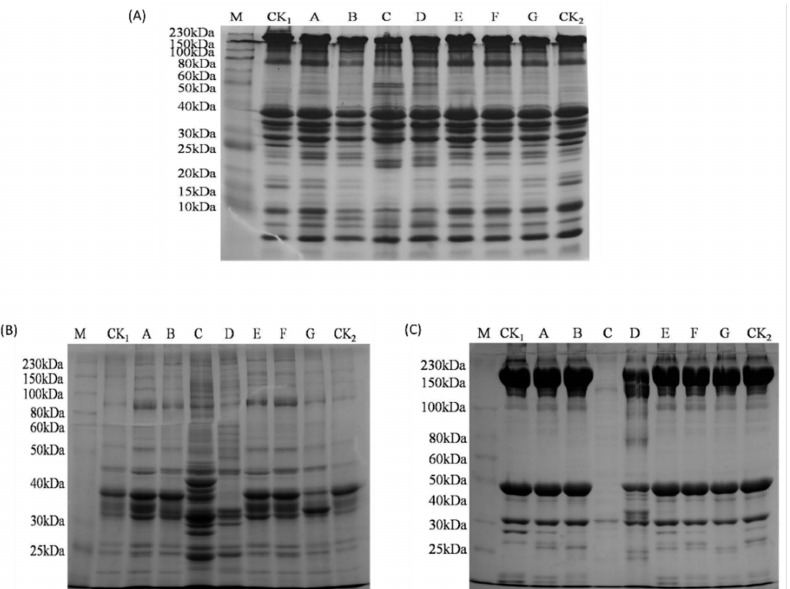
Figure 3. SDS-PAGE analysis of total soluble protein ( A ), water soluble protein ( B ), and salt soluble protein ( C ) of sturgeon fillets inoculated with different bacterial groups and stored aerobically on ice for 18 d. M, protein marker; CK1, control (stored for 0 d); A, Shewanella putrefaciens ; B, Shewanella baltica ; C, Pseudomonas fluorescens ; D, Pseudomonas mandelii ; E, Pseudomonas sp. J-10; F, Pseudomonas fragi ; G, Pseudomonas deceptionensis ; CK2, control (stored for 18